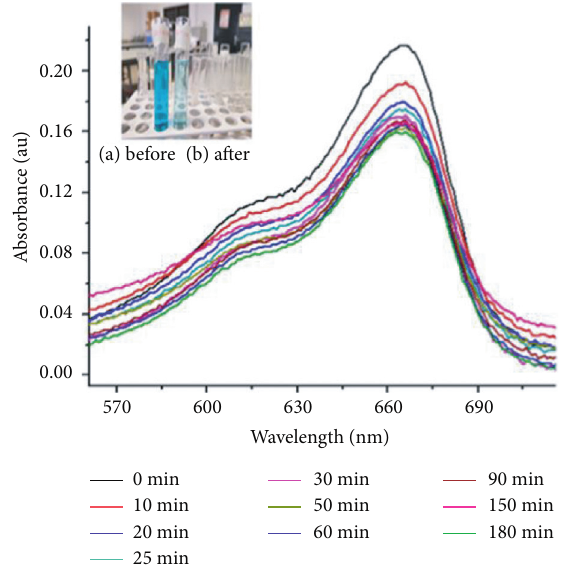
Figure 12: Absorbance intensity curve at various time intervals adopted from the work of Nyankson et al.